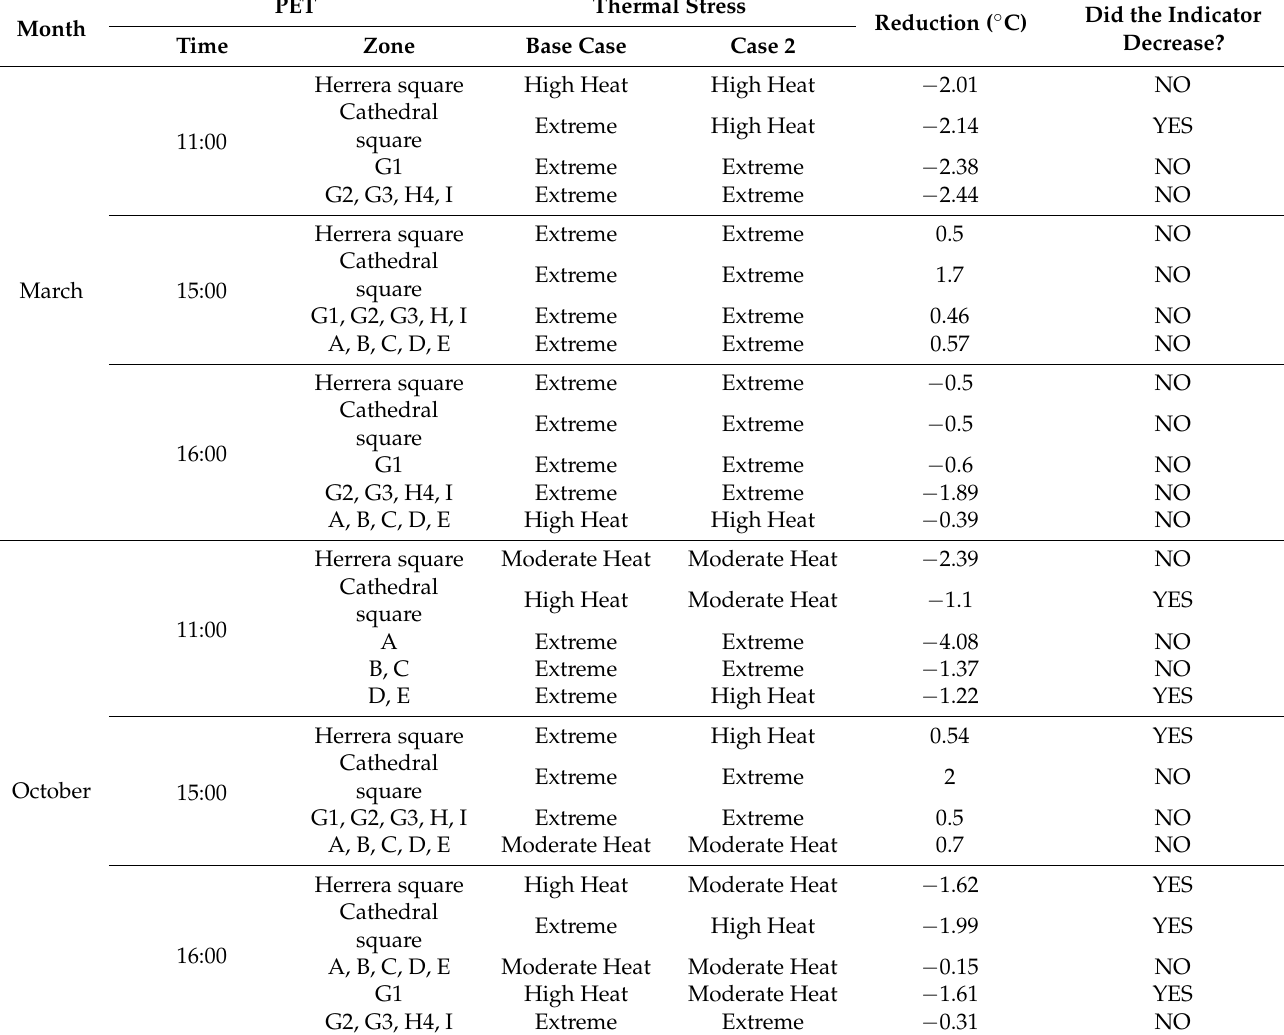
Table 6. Comparison for PET for base case and case 2 by streets for critical